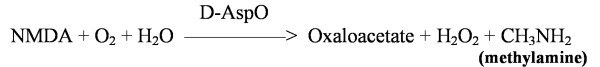
Oxidation reaction of NMDA by D-Aspartate oxidase and production of methylamine (CH3NH2).